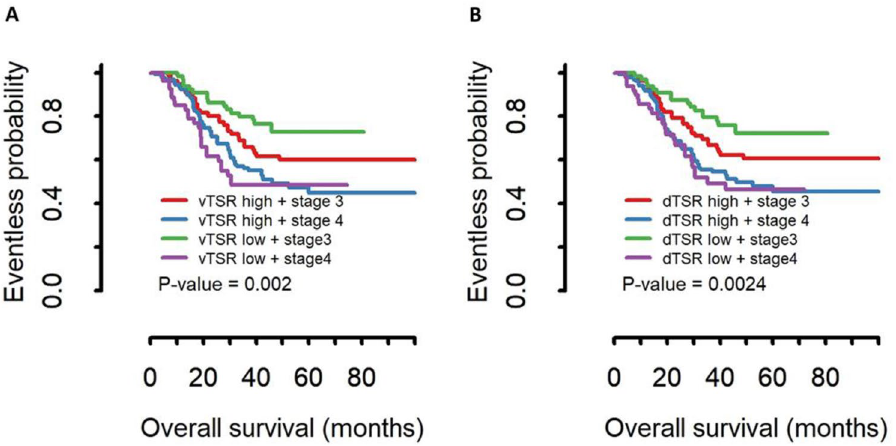
Figure 8. Kaplan–Meier curve of the overall survival of patients stratified by tumor–stroma ratio (TSR) measured by pathologists (vTSR) ( A ) and TSR using the deep learning metrics (dTSR) ( B ) for gastric